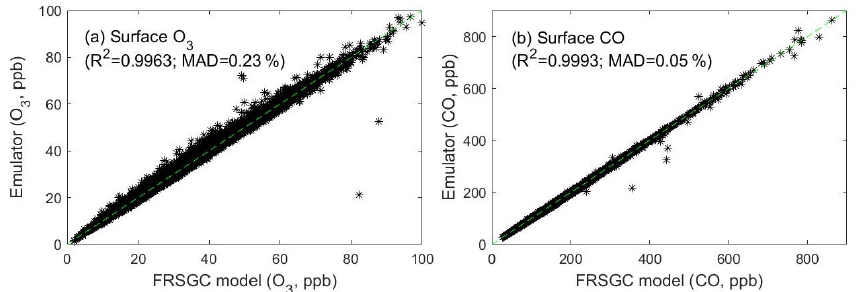
Figure 3. Simulated surface O 3 (a) and surface CO (b) from the FRSGC/UCI CTM versus those predicted from the Gaussian process emulators. The simulated and emulated concentrations were generated using 20 sets of model parameters that were not used for training the